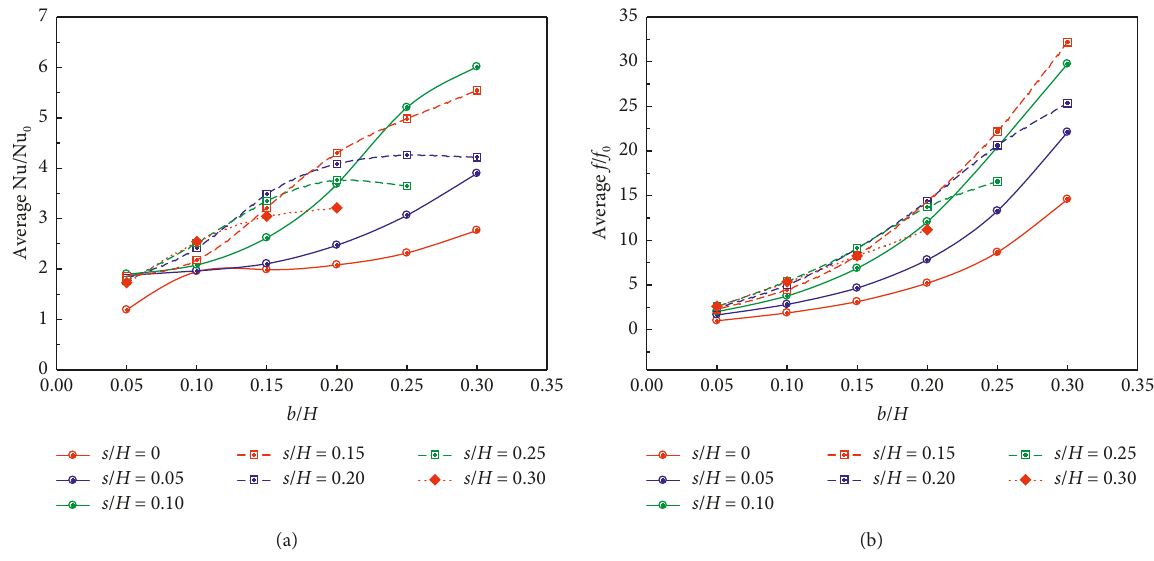
Figure 22: (a) Average Nu/Nu 0 vs b / H and (b) average f / f 0 vs b / H for the heat exchanger square duct installed with the 45